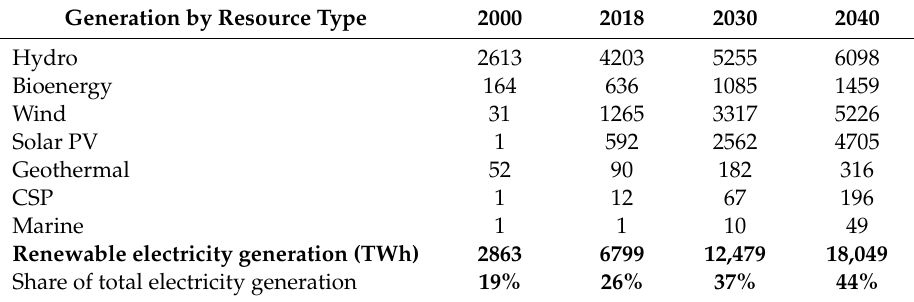
Table 1. Global renewable energy consumption for electricity generation